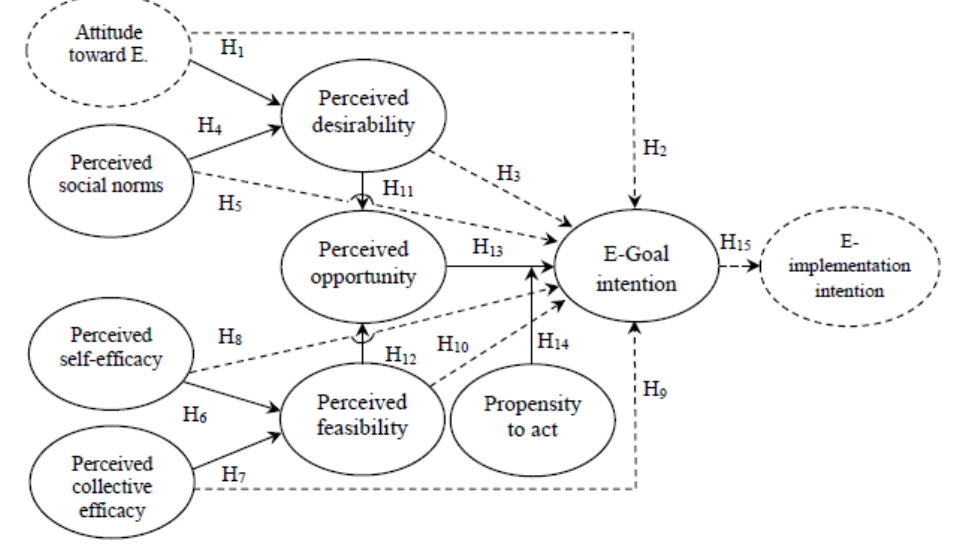
Figure 2: Entrepreneurial Implementation Intention (EII) Model, Source: (Esfandiar et al., 2019) Vocational Perception